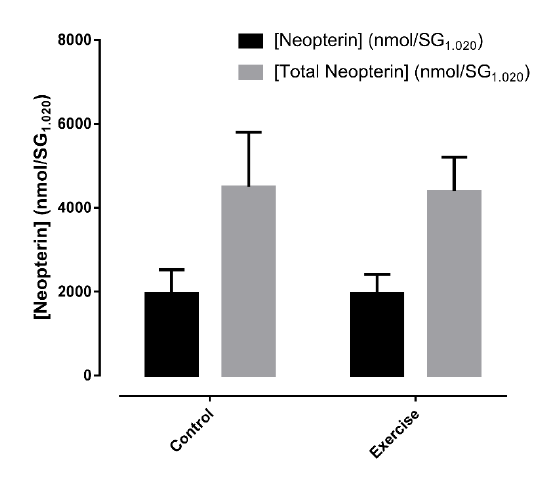
Figure 6: Urinary neopterin (black) and total neopterin (grey) were analysed using SCX-HPLC. Urine was collected for 24 hours following the control period, or post-exercise, before being analysed. There was no change in neopterin or total neopterin between the control and exercise groups. Data is presented as means with 95%